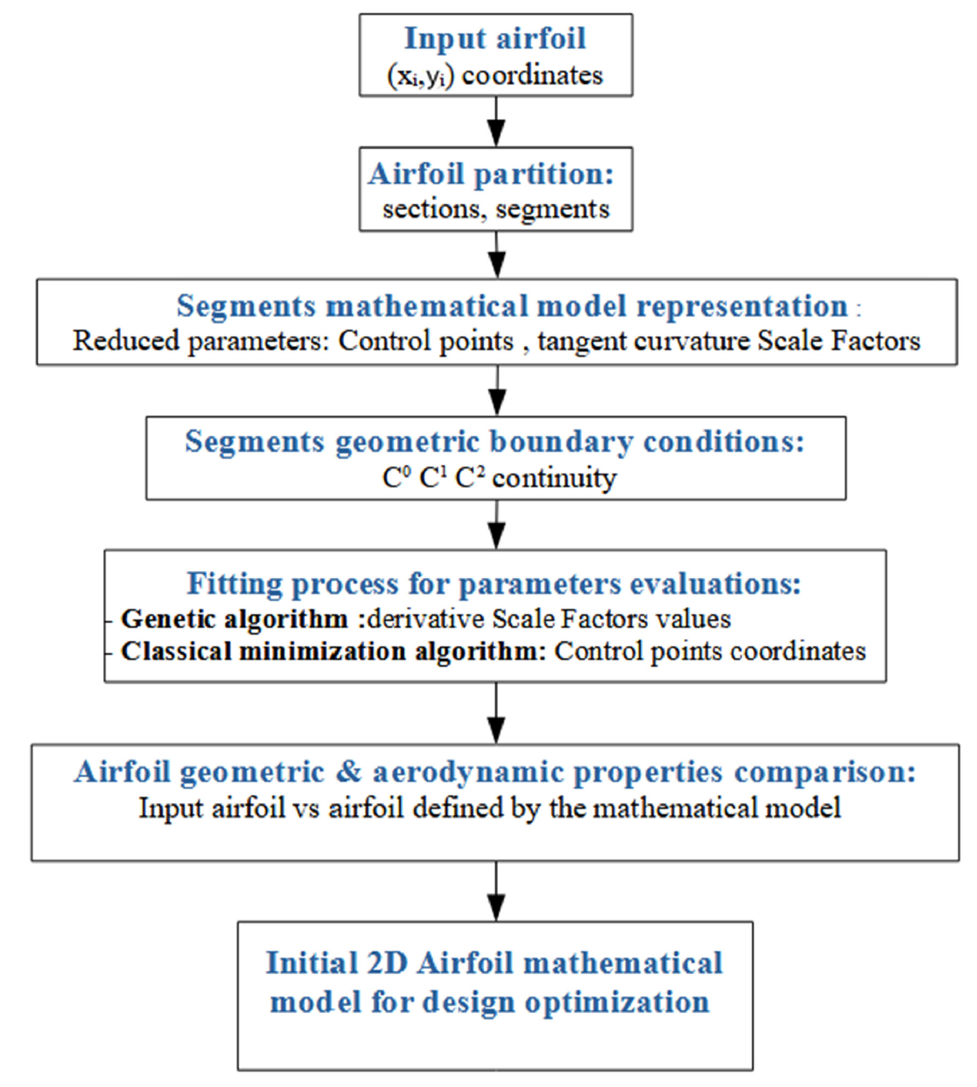
Figure 4. 2D airfoils mathematical model flowchart